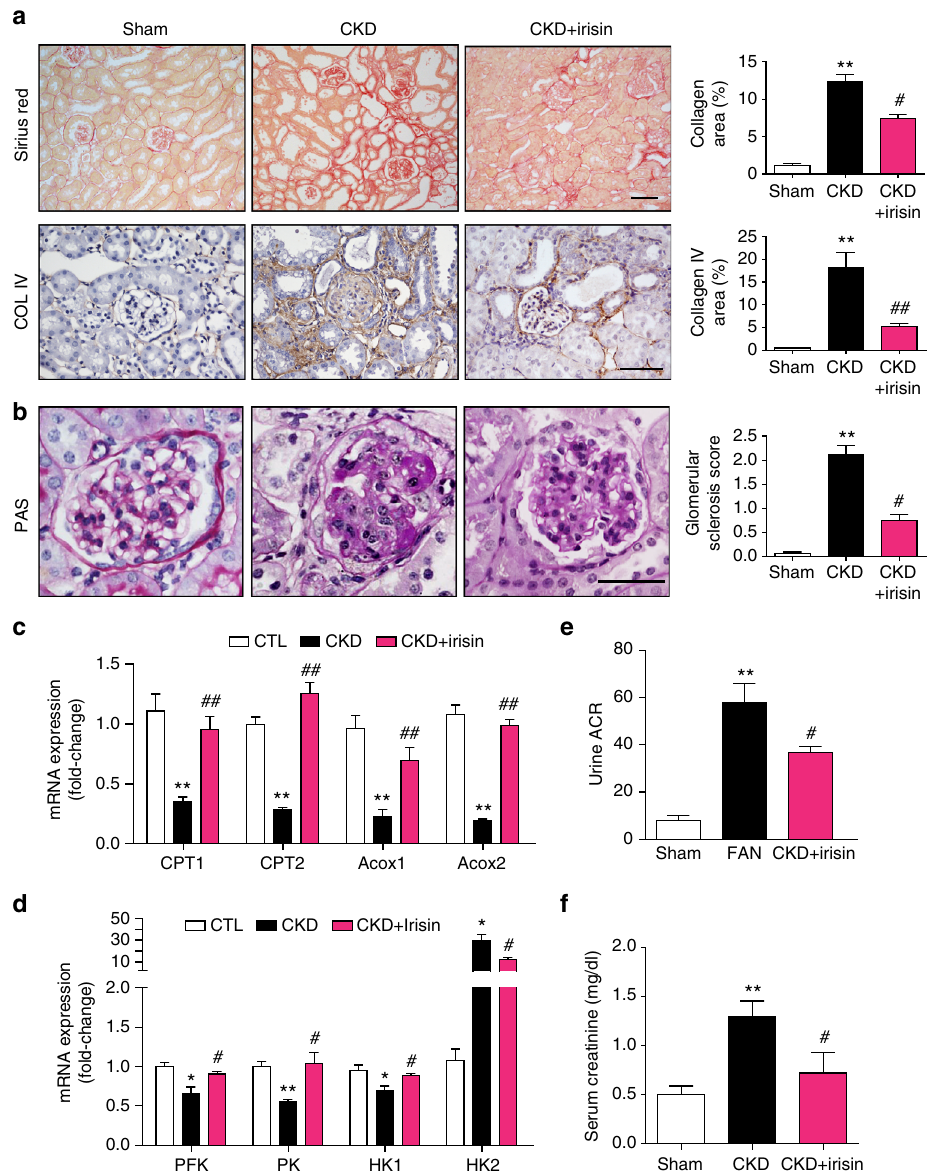
Fig. 8 Recombinant irisin administration improves kidney function and reduces the development of CKD. a Representative images of sirius red staining (upper panel), immunohistochemistry staining for COL IV (lower panel), in subtotal nephrectomy (CKD) mice treated with irisin for 8 weeks. Quantitative analysis of collagen or COL IV in different groups as indicated. ** P < 0.01 for CKD vs. Sham, # P < 0.05 or ## P < 0.01 for CKD + irisin vs. CKD ( n = 5 per group, one-way ANOVA with Bonferroni ’ s multiple comparison test). Scale bars, 50 μ m. b Representative images of PAS staining in subtotal nephrectomy (CKD) mice treated with or without irisin. Sclerosis index score was shown in left panel. ** P < 0.01 for CKD vs. Sham, # P < 0.05 for CKD+ irisin vs. CKD ( n = 5 per group, one-way ANOVA with Bonferroni ’ s multiple comparison test). Scale bars, 50 μ m. c and d Real-time qPCR analysis of enzymes expression in glycolysis pathway and fatty acid oxidation pathway. Data were presented as mean ± s.e.m.; * P < 0.05 or ** P < 0.01 for CKD vs. Sham and # P < 0.05 or ## P < 0.01 for CKD + irisin vs. Sham, n = 5 per group (one-way ANOVA with Bonferroni ’ s multiple comparison test). e and f Kidney function (assessed by serum creatinine and urinary albumin creatinine ratio) was assessed in CKD mice after irisin treatment. Data were presented as mean ± s.e.m. ( n = 5 per group, ** P < 0.01for CKD vs. Sham. # P < 0.05 for CKD+ irisin vs CKD, one-way ANOVA with Bonferroni ’ s multiple comparison